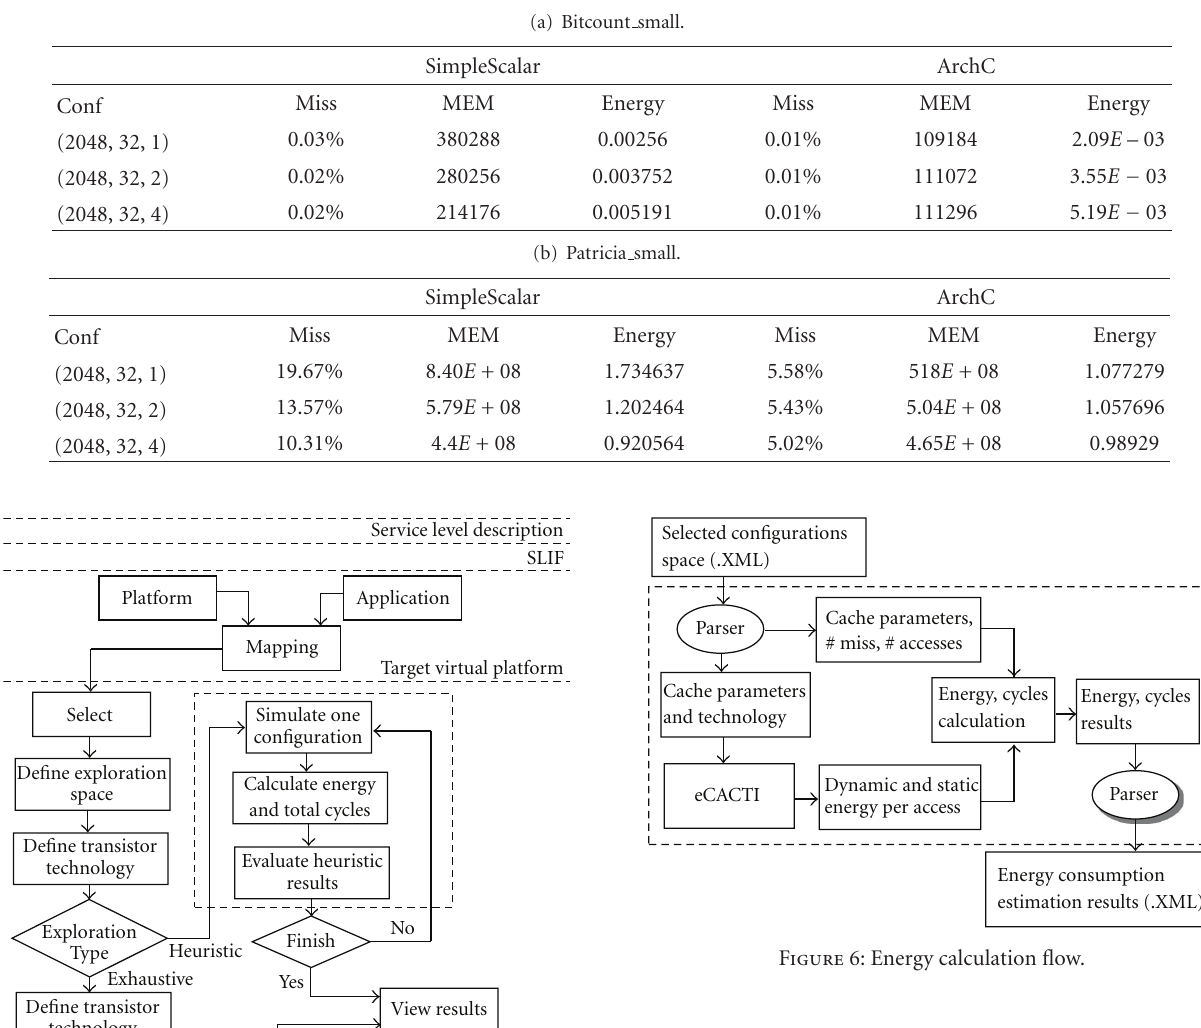
Table 3: Energy evaluation for two applications ( bitcount small, patricia small ).